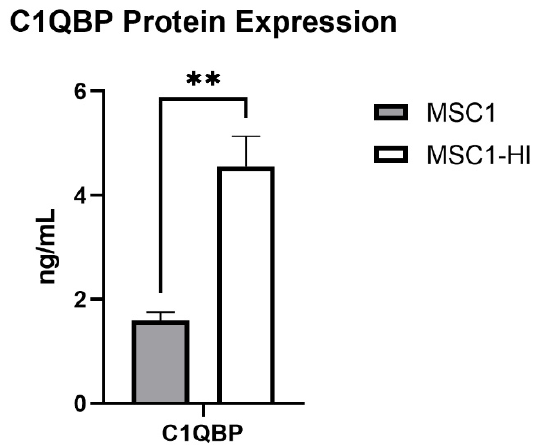
Figure 10. MSC1 and MSC1-HI cells express and secrete protein for complement inhibitor C1QBP. Conditioned media from MSC1 cells (gray bar) or MSC1-HI cells (white 7 bar) were analyzed for protein levels of the complement inhibitor C1QBP, which were expressed at 1.593 ± 0.161 ng/mL by MSC1 cells and at 4.560 ± 0.541 ng/mL by MSC1-HI cells. Asterisks denote significance through unpaired t- test with Welch correction. ** p < 0.01.